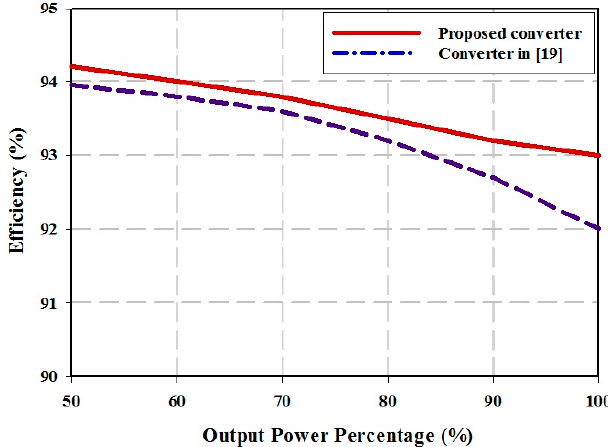
Figure 16. Efficiency plot of the implemented prototype under different load conditions. Figure 16. E ffi ciency plot of the implemented prototype under di ff erent load